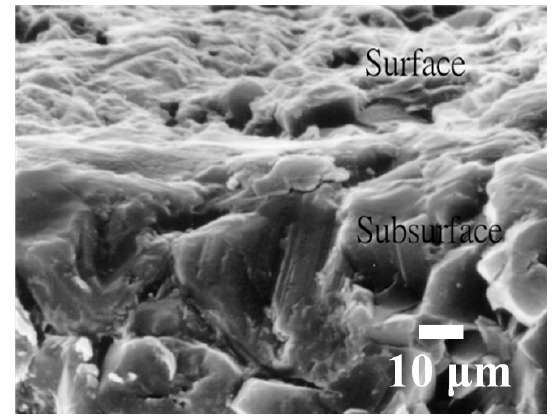
Figure 22. Images of subsurface regions using swinging WSM.